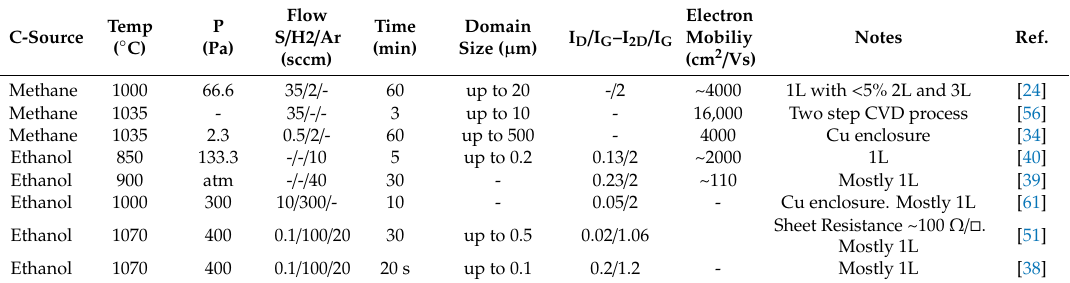
Table 1. Summary of selected methane and ethanol CVD conditions reported in literature to grow high quality continuous graphene films on Cu